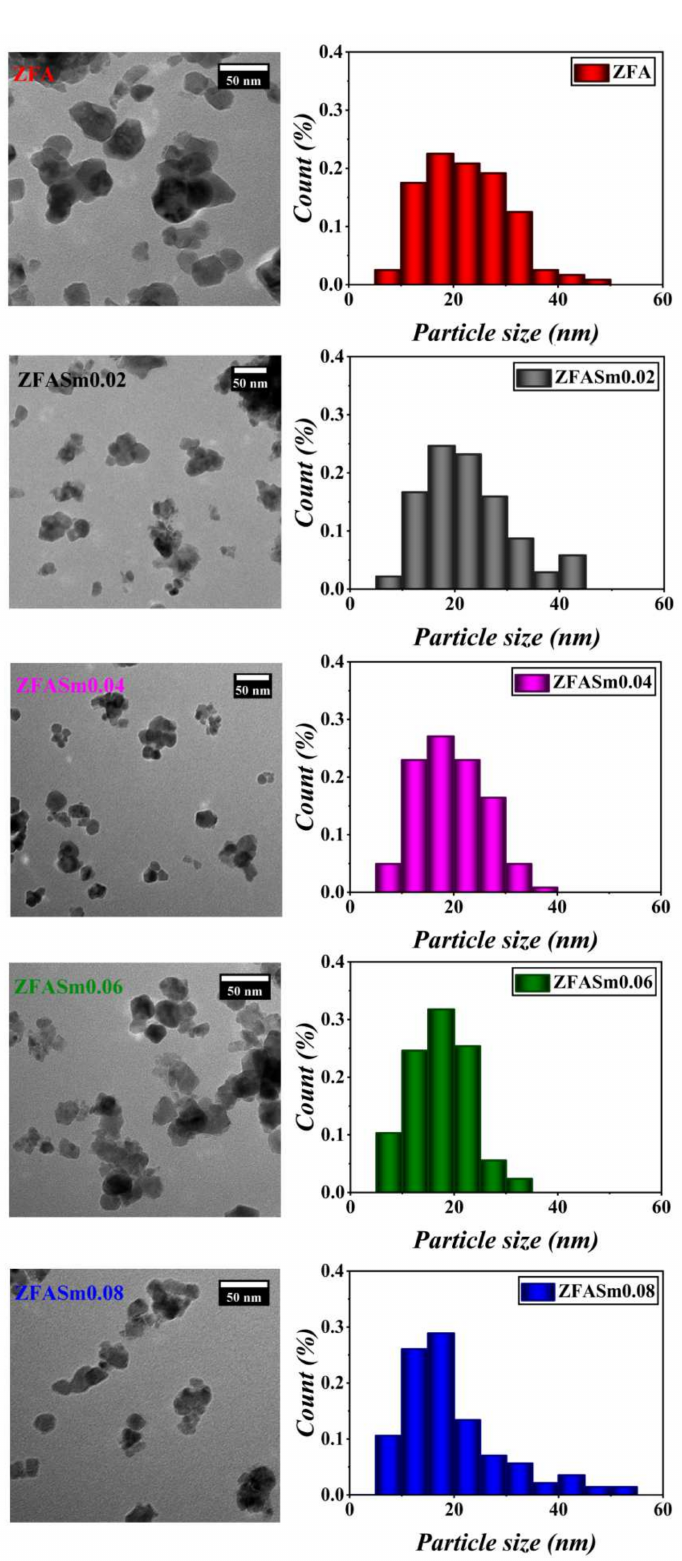
Figure 3. Representative TEM micrographs (left) and particle-size distributions (right)